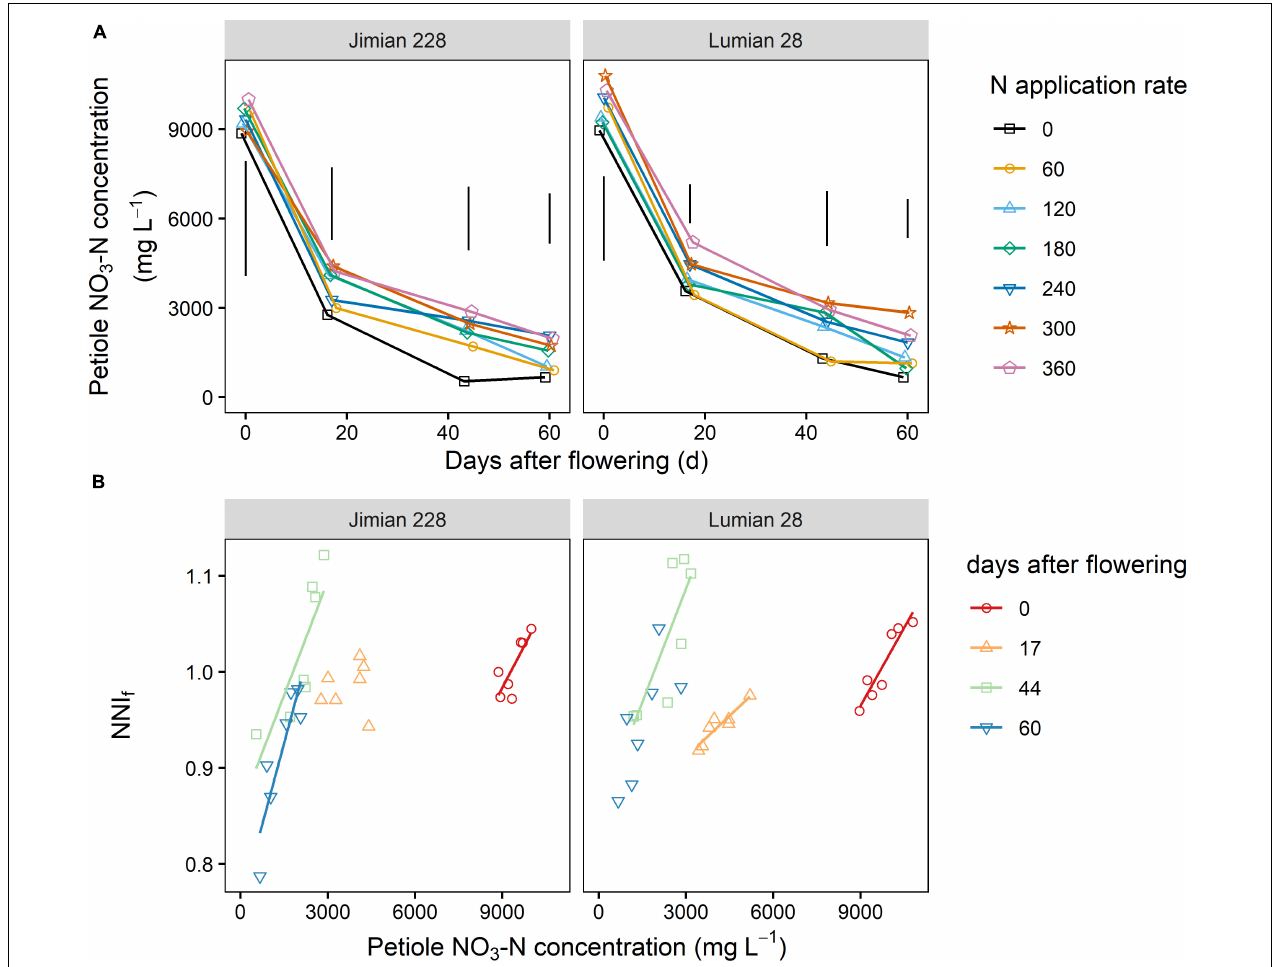
FIGURE 8 | Petiole NO 3 -N concentration (A) and its relationship to the fruits nitrogen nutrition index (NNI f ) (B) for Jimian 228 and Lumian 28 in 2019. Data show means of the three replicate plots. The NNI f is calculated as the ratio between the actual fruits N concentration and the critical fruits N concentration. (A) The vertical bars indicate Tukey’s HSD error bars at each sampling date. Full model ANOVA results are provided in Supplementary Table 6 . (B) The color solid lines represent significant linear relationships ( P < 0.05); non-significant relationships are not shown ( P >